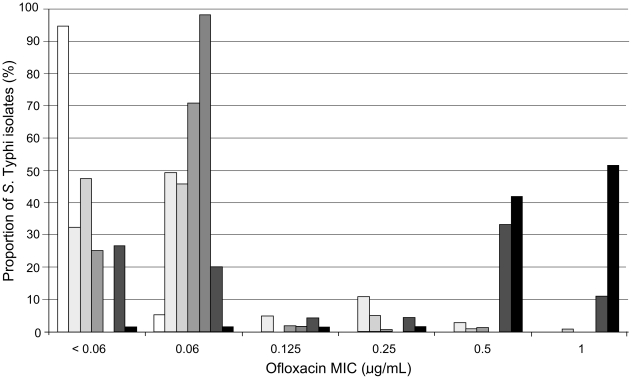
The distribution of S. Typhi MIC to ofloxacin in seven RCTs.Histogram showing the distribution of S. Typhi MICs (<0.06, 0.06, 0.125, 0.25, 0.5 and 1 µg/mL) to ofloxacin over seven individual randomised. The proportion of S. Typhi strains with the corresponding MIC are shaded accordingly, white; study TY1 (1992–1993) n = 19 [25], very light grey; study CT1 (1993–1994) n = 102 [26], light grey; study TY2 (1993–1996) n = 103 [24], mid grey; study DTC (1994–1995) n = 154 [28], dark grey; study DN (1995–1996) n = 55 [29], very dark grey; study TY3 (1997–1998) n = 45 [23] and black; study DTY2 (1998–2001) n = 62 [27].